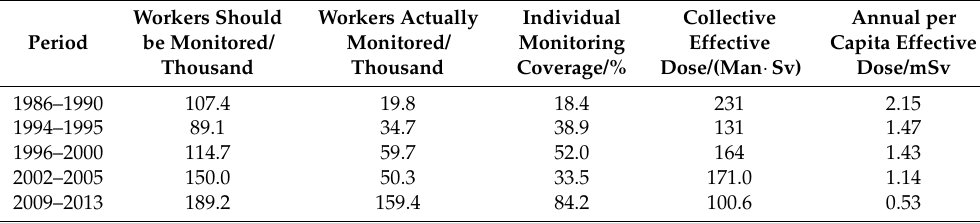
Table 2. Dose levels of occupational exposure in medical applications (1986–2013).